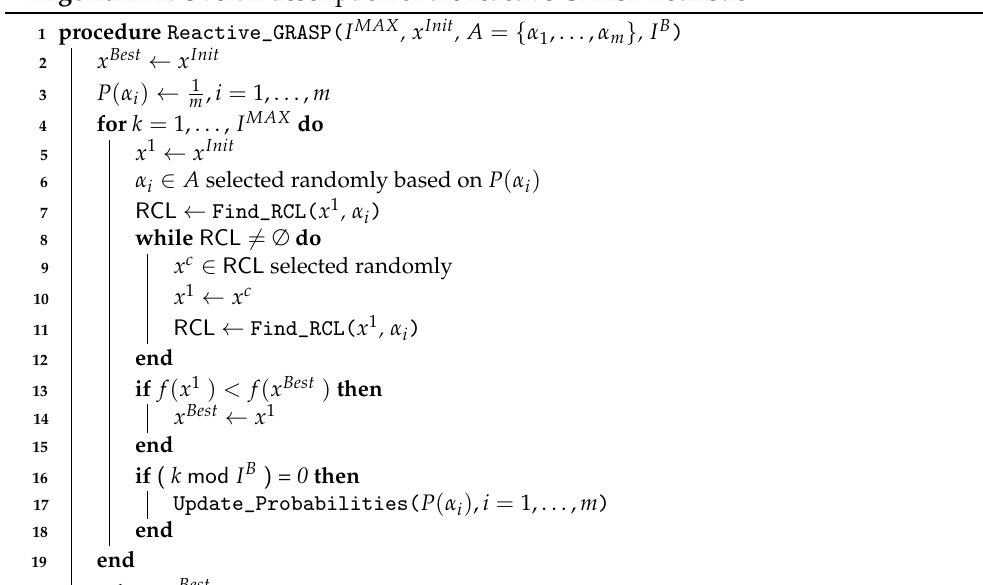
Algorithm 1: Overall description of the reactive GRASP